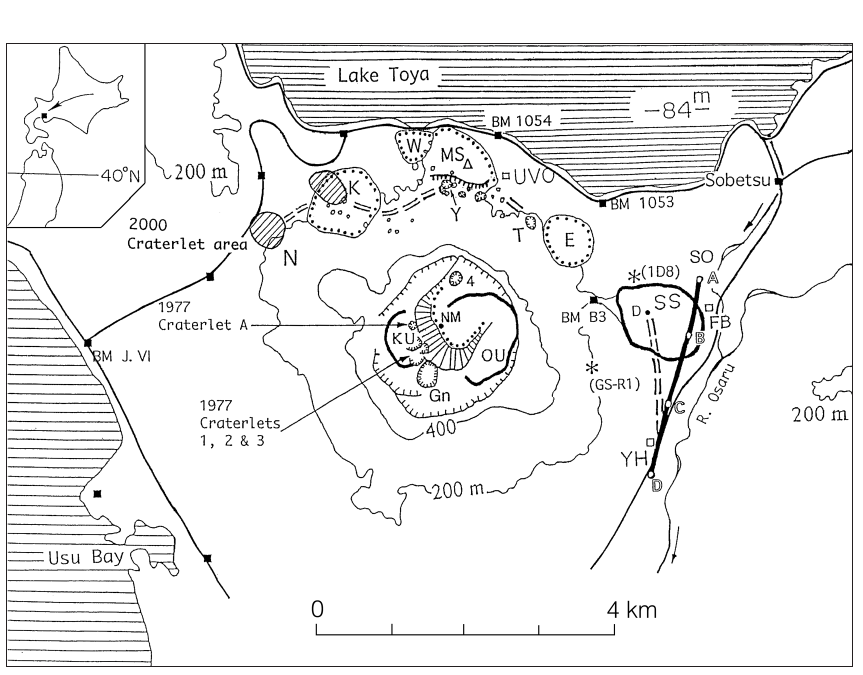
Fig. 4. Topographic sketch map of Usu volcano as of 2002. Thick contours show lava domes and those with dots volcanic mounds. SS – the 1944 lava dome (Showa-shinzan); MS – the 1910 mound; KU – the 1663 or 1769 lava dome; OU – the 1853 lava dome. A thick line AA-BB-CC-DD shows route of precise levels. Double broken lines indicate migration trend of volcanic activity. YH – Yanagihara village; SO – Sobetsu village; (GS-R1), (1D8) – test wells; Y and T – craterlets of the 1910 eruption; E and W – mounds formed in the prehistoric times; K and N – explosion areas of the 2000